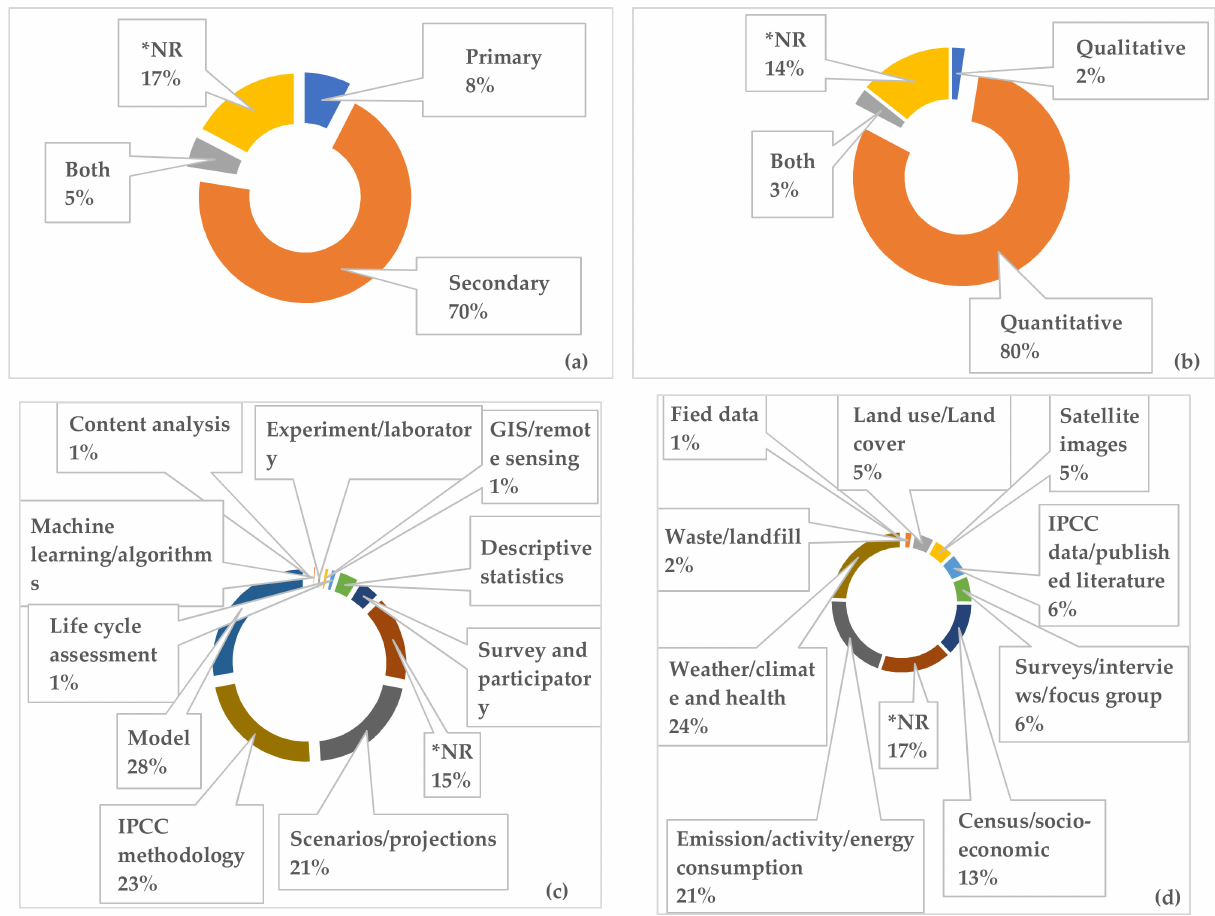
Figure 4. Data sources ( a ), approach to data analysis ( b ), methodology ( c ), and data types ( d ) of the literature used in the review. Note: *NR indicates studies that did not report any data source, approach to data analysis, methodology, and data